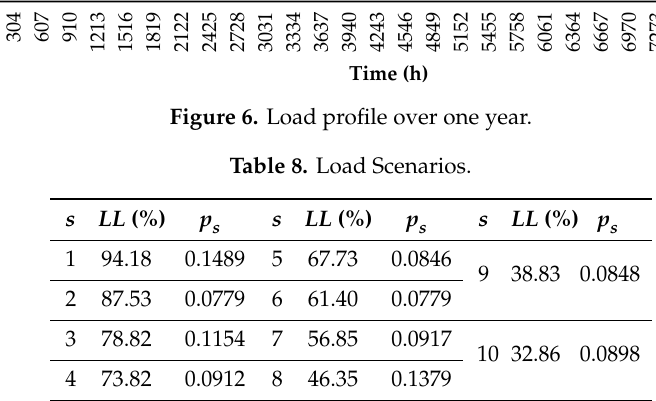
Table 9. Probabilistic results for the 59-node distribution system. Optimizer